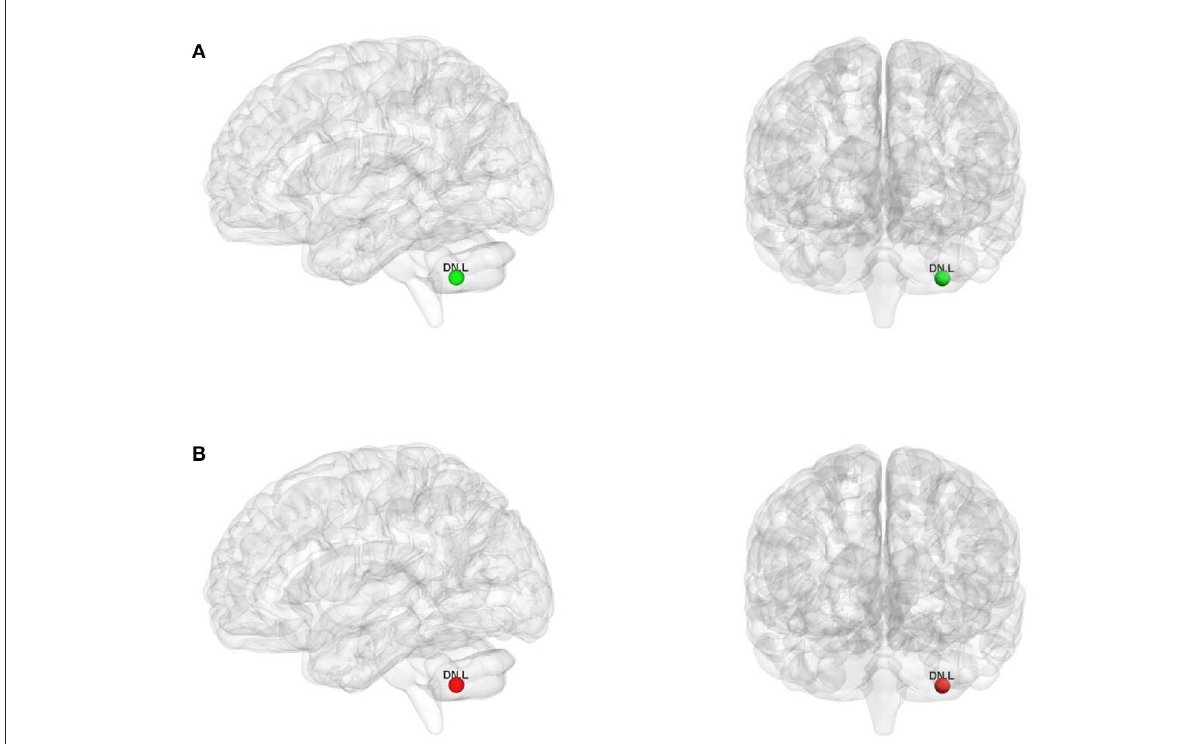
FIGURE3 The nodes with increased nodal degree in Wilson’s disease patients for the binary graphs (A) and weighted graphs (B) of the motor execution network. Node sizes represent T values. DN, dentate nucleus; L, left; R, right.